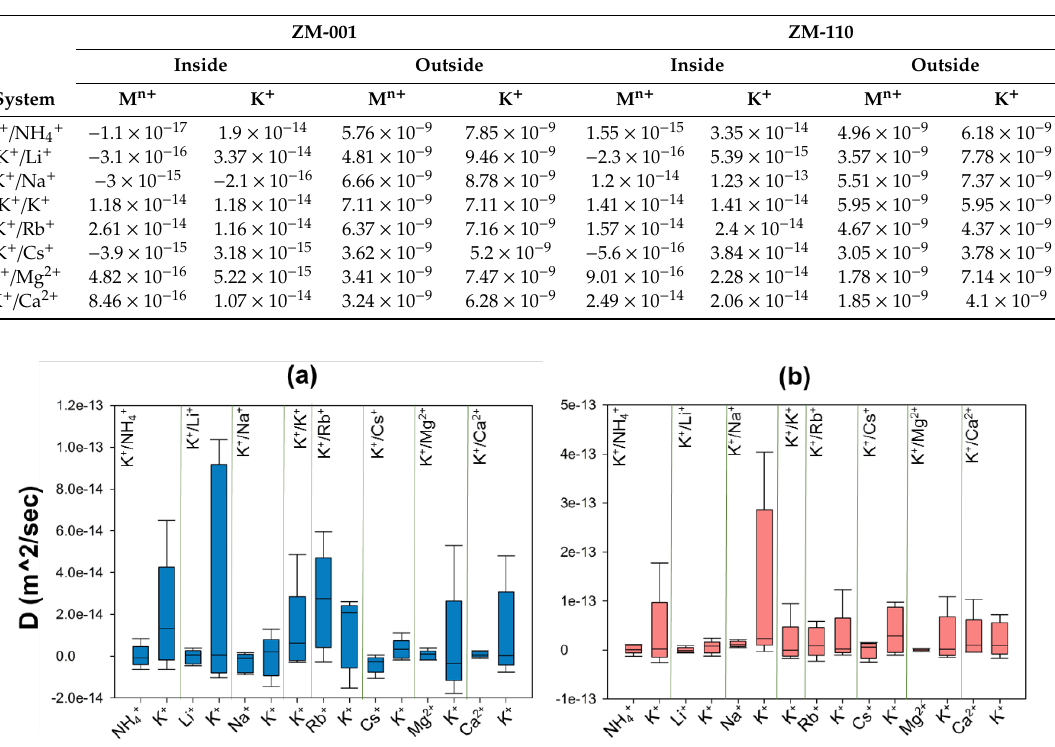
Figure 6. The diversity of self-diffusion coefficients for K⁺ and M n ⁺ guest cations of each exchanging system inside ( a ) ZM-001 and ( b ) ZM-110 membranes.